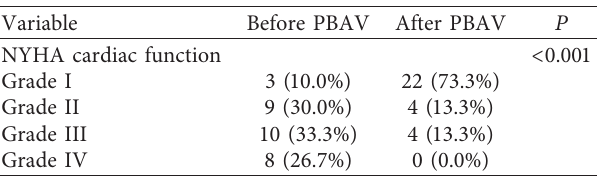
Table 2: Comparison of preprocedural and postprocedural cardiac function.